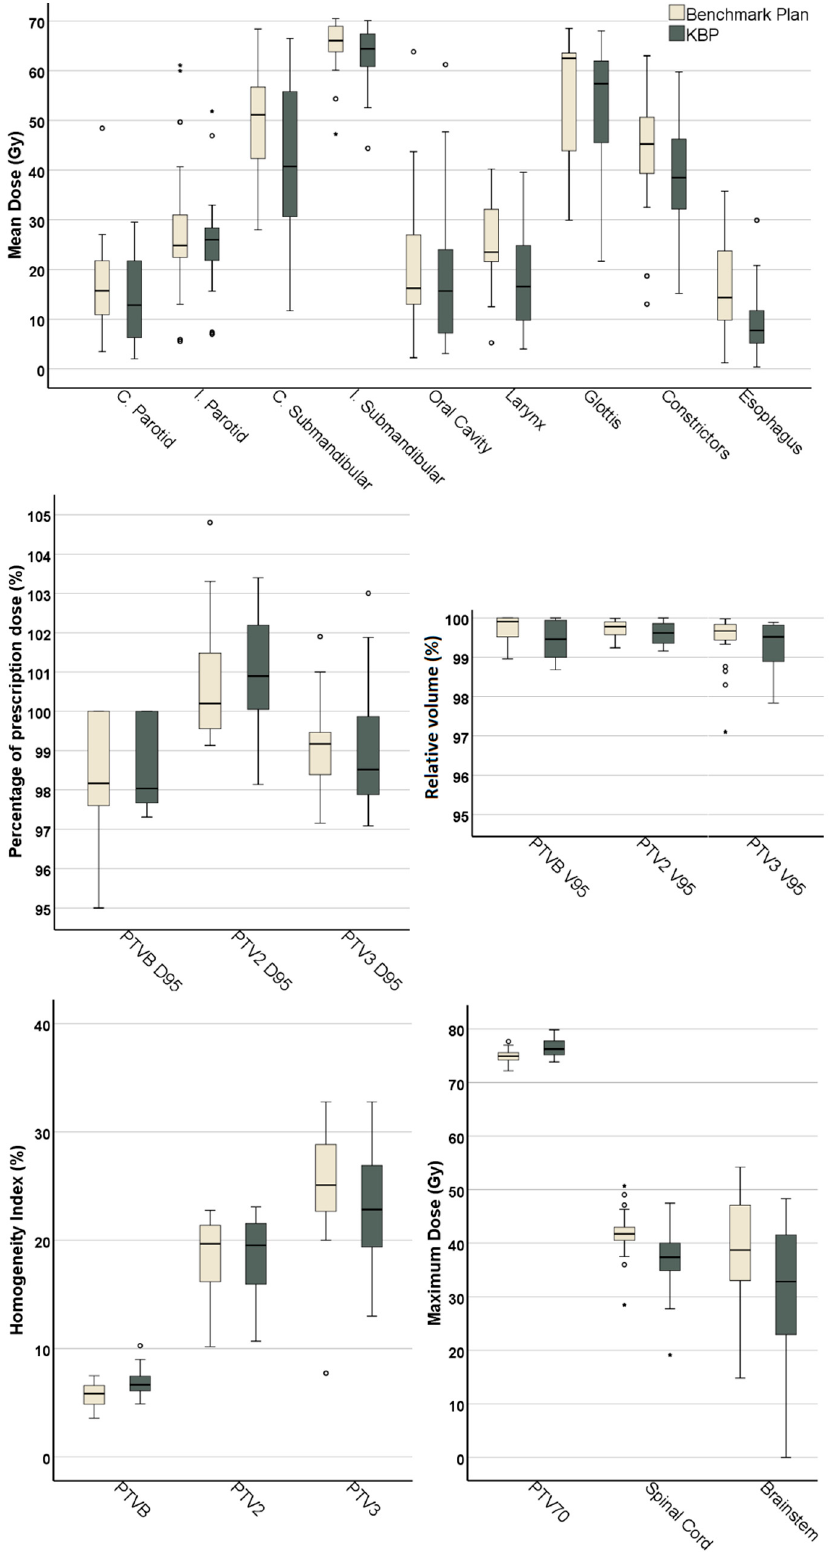
Figure 1. Box-whisker plots for all 21 patients from external centers. Dark-line in the middle of box denotes the median while the top/bottom of the box indicates 75th/25th percentile. A structure denoted with “*” indicates a statistically significant difference between benchmark plans and knowledge-based plans (KBPs) for said structure.